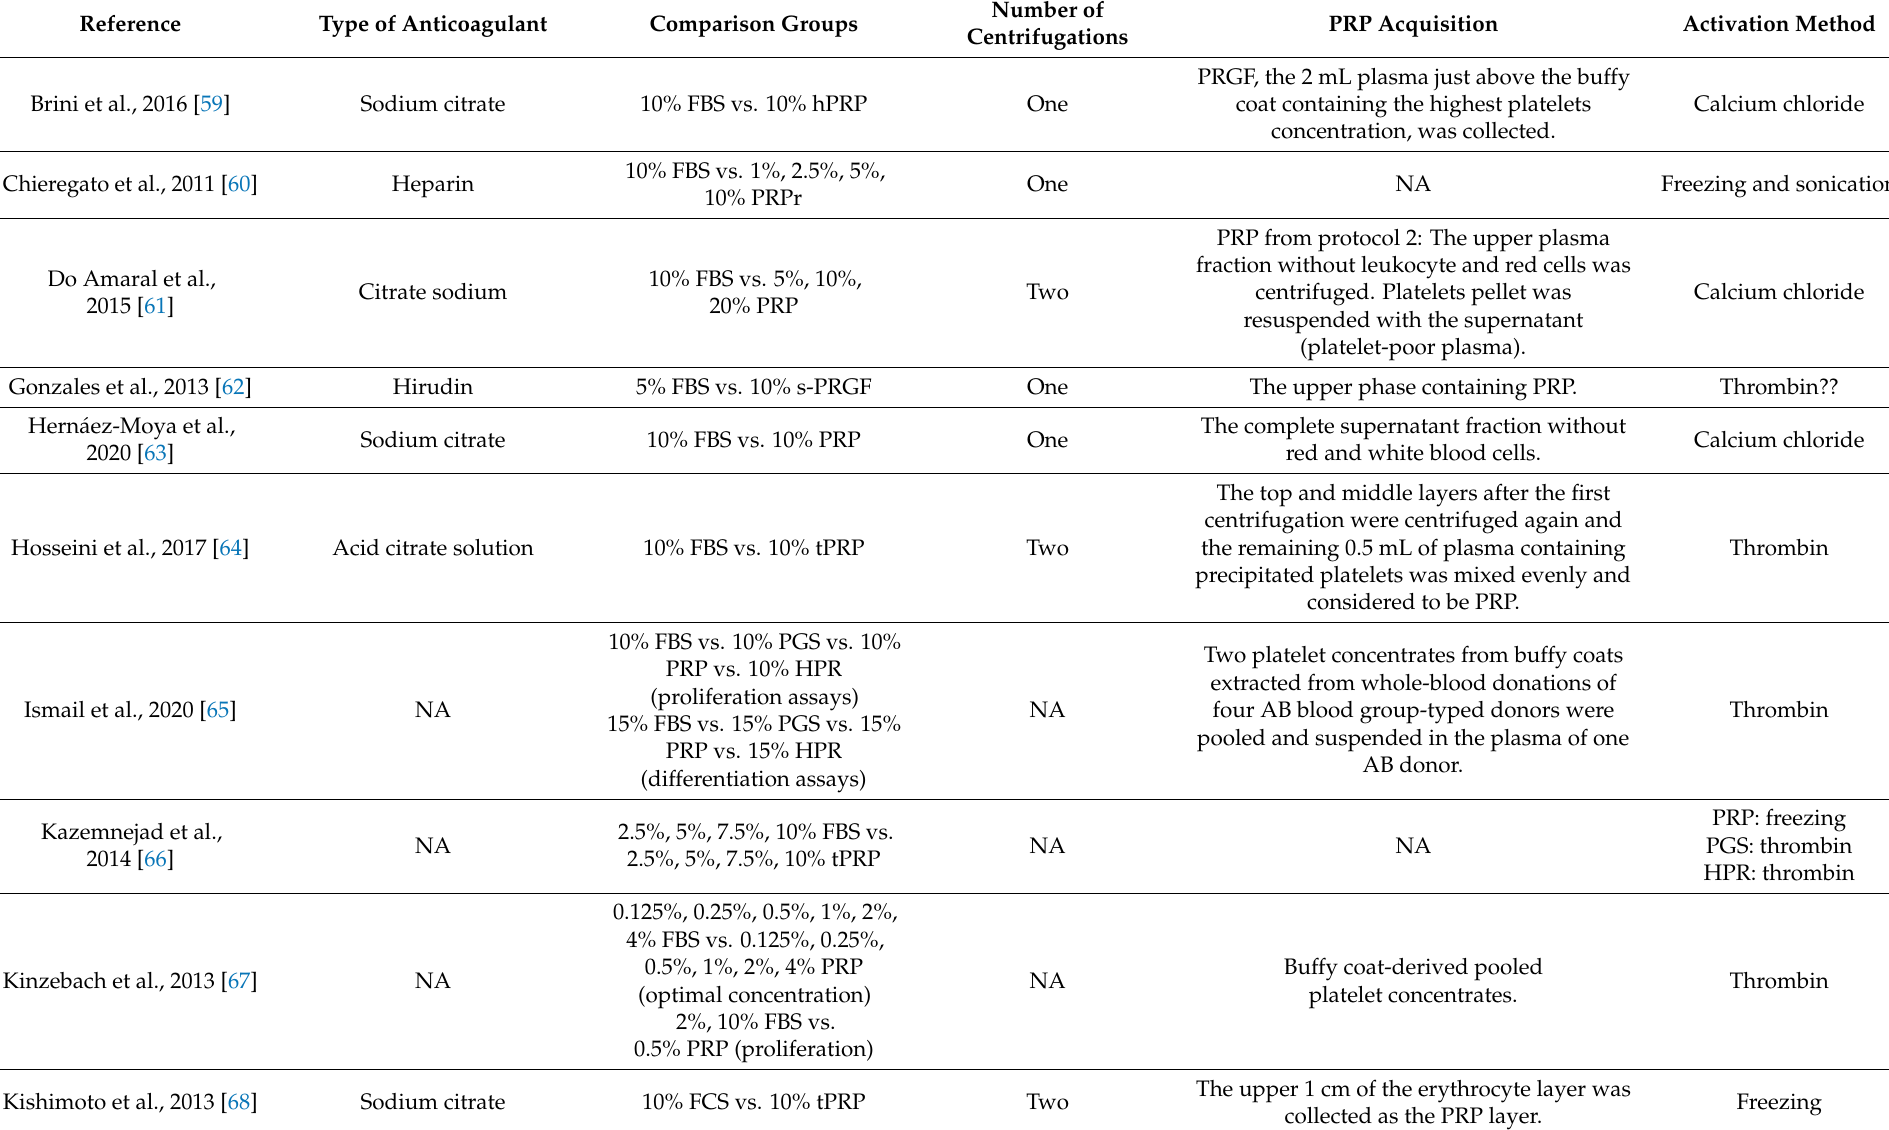
PRP from protocol 2: The upper plasma fraction without leukocyte and red cells was resuspended with the supernatant (platelet-poor plasma).